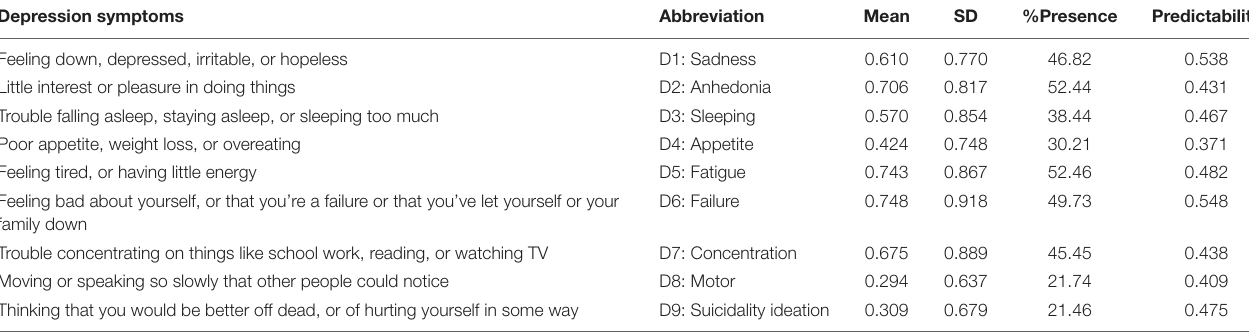
TABLE 2 | Abbreviation, Mean, Standard Deviation, and Presence of PHQ-A Symptoms. Depression symptoms